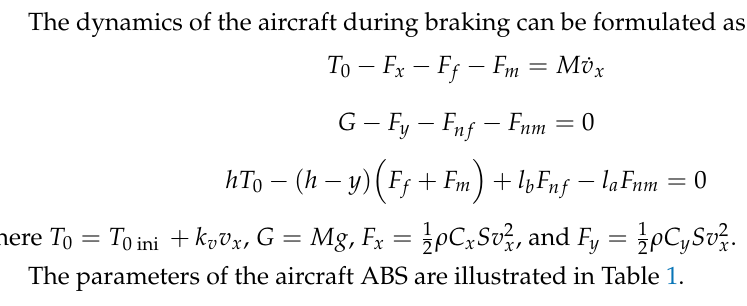
Figure 6. Schematic diagram of the force of the aircraft